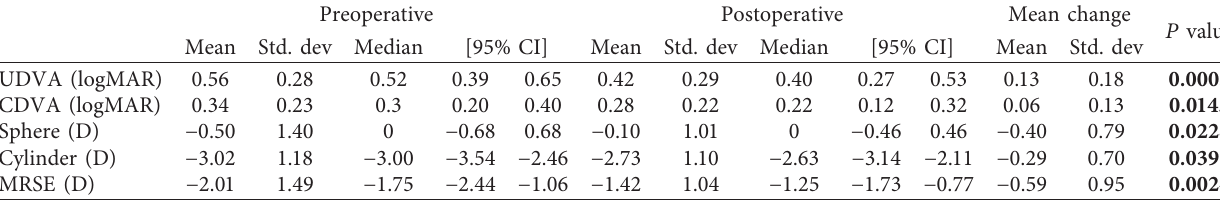
Table 1: Visual and refractive outcomes after accelerated cross-linking in pediatric keratoconus.